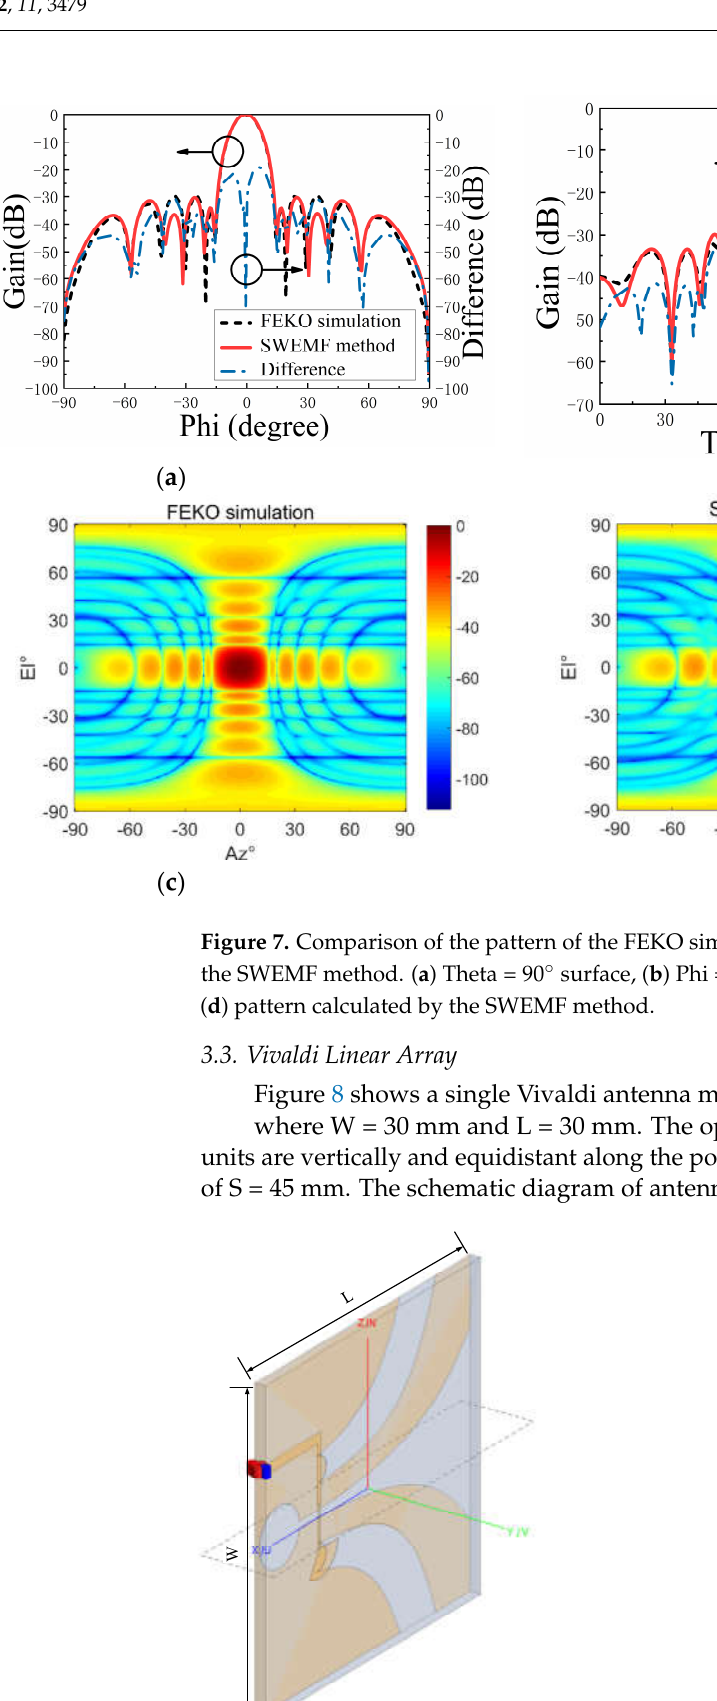
Figure 8. Vivaldi antenna model.